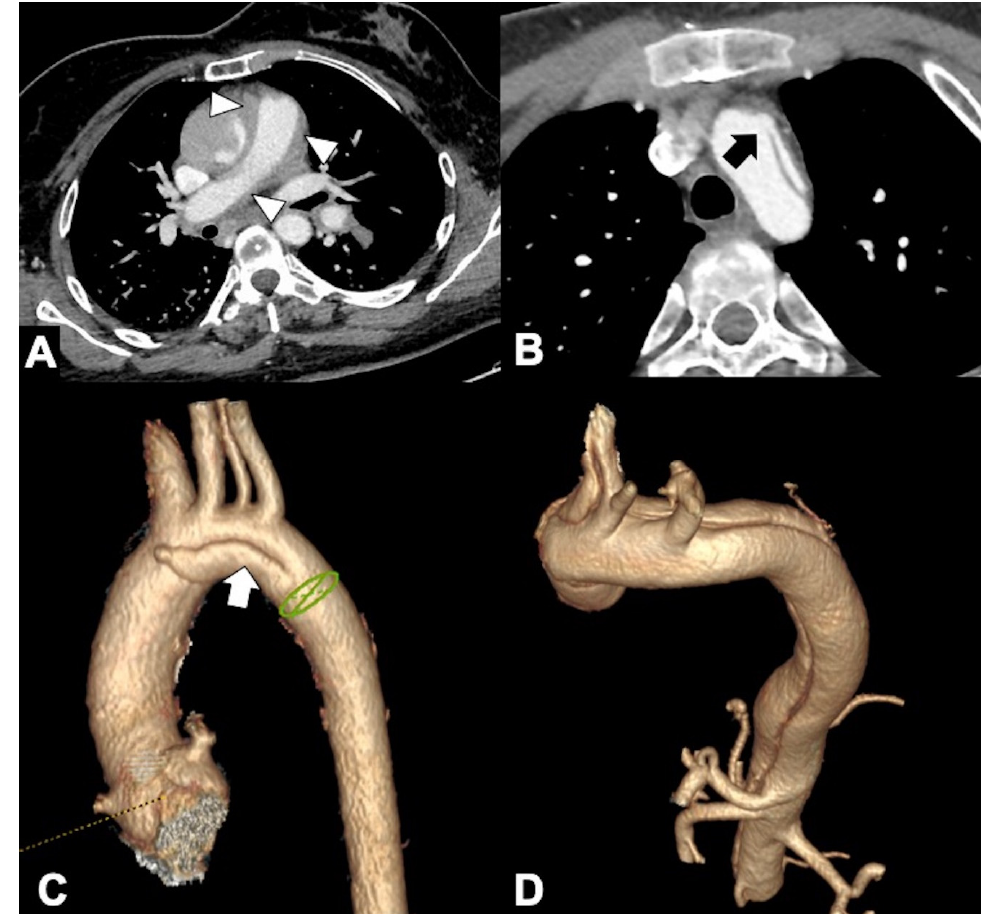
Figure 7. ( A ) Axial CTA image demonstrates thickening of the main pulmonary arterial wall (arrowheads) indicating IMH of the PA in ruptured Type A AD. ( B ) Axial CTA image shows entry tear (arrow) in the arch convexity in a 53-year-old man with severe chest pain. ( C ) 3D-VR parasagittal reconstruction image shows localized 4-vessels arch dissection (arrow) without supra-aortic trunks involvement. ( D ) 3D-VR parasagittal reconstruction image shows a non-A-non-B dissection with arch-entry and anterograde descending aorta involvement.